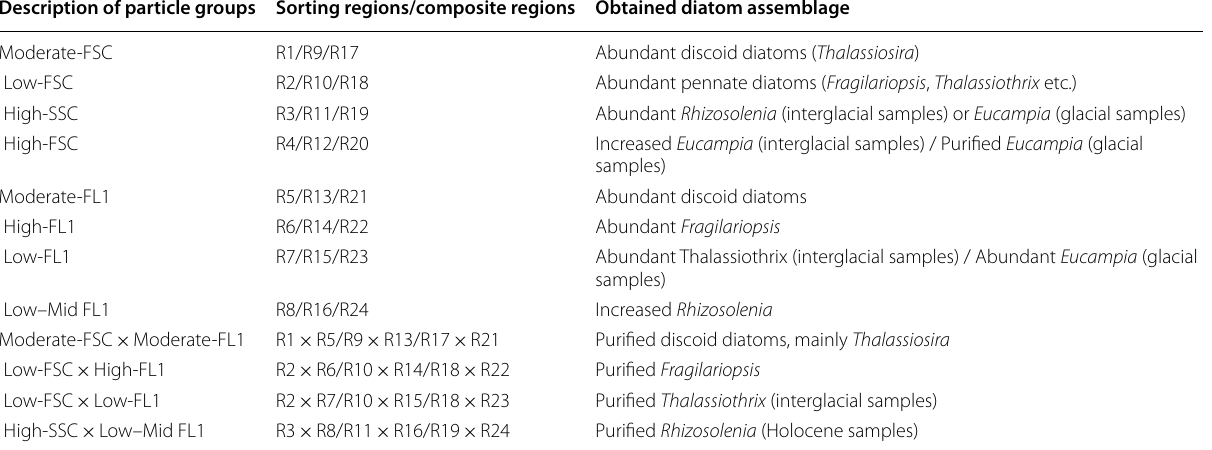
Table 1 Summary of the characteristics and diatom assemblages of the sorting regions and composite regions Description of particle groups Sorting regions/composite regions Obtained diatom